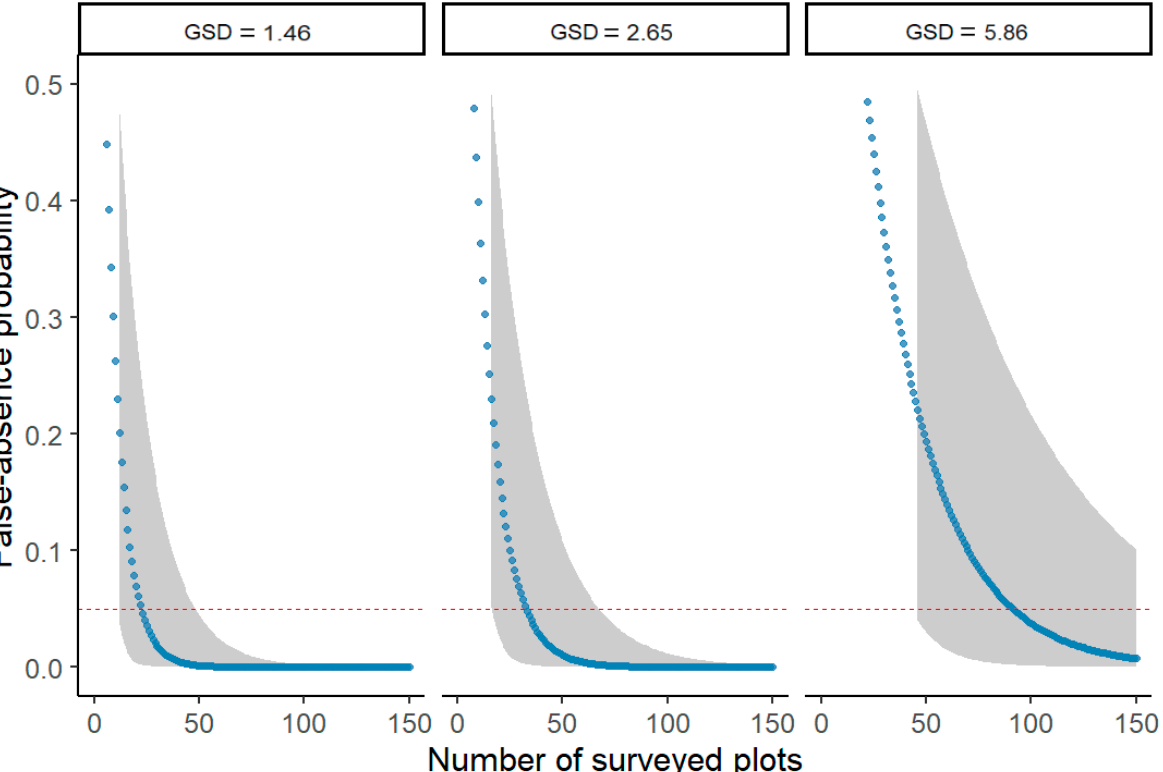
Figure 5. Estimated probability of false negative detections during missions where no chimpanzee nests were detected using the formula developed by [37,46]. Estimated probabilities of false negative detections decline with increasing numbers of plots as spatial replicas surveyed during a mission depending on the GSD. Here, we present examples of the lowest GSD (1.46 cm), median GSD (2.65 cm), and highest average GSD (5.86 cm) applied during missions. The red line indicates the 95% probability criterion for a true negative detection.